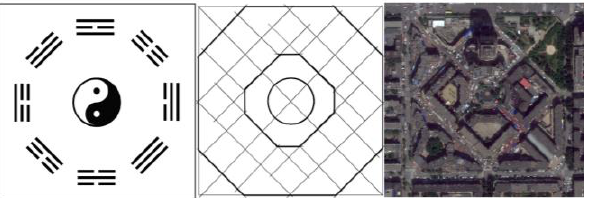
Figure 5. LIV of Shenyang 1927